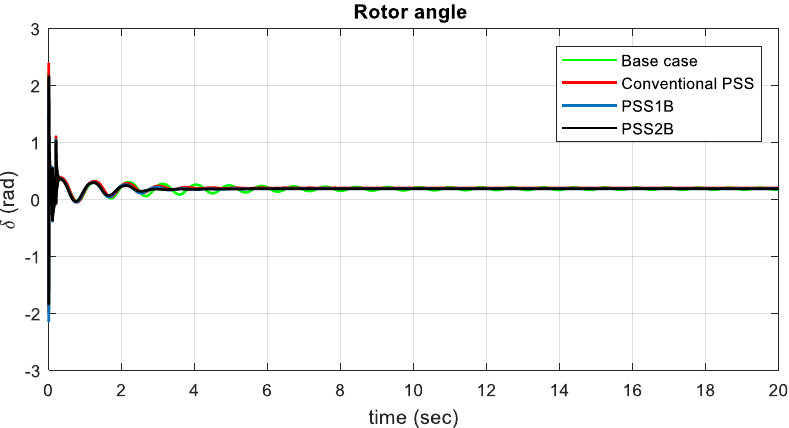
Figure 15. Rotor angle ( 𝛿 ) of the power system at normal loading.